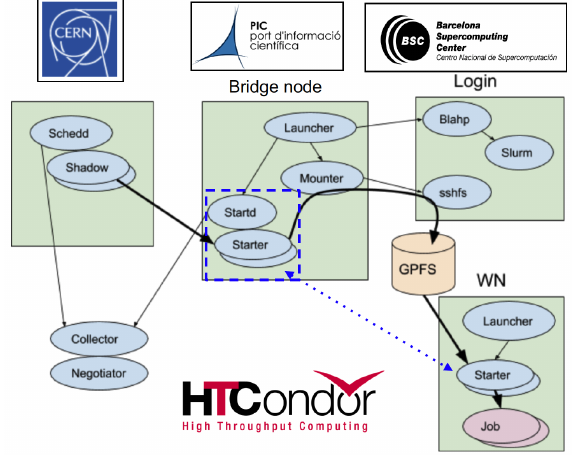
Figure 4. HPC resources at BSC integration model into CMS computing using communication via FS to replace WAN. A brid g e node installed at PIC submits Slurm jobs to BSC queues, that, upon execution, instantiate HTCondor starters on the BSC WN. These starter processes update their status to the mirror starter processes running at PIC, at the other side of the network barrier. In order to enable this mirroring, job input sandboxes and status signals are regularly synchronized between the bridge to the WN at BSC, passing .tar files via gpfs. The startd process at PIC opens to matchmaking by CMS job schedds at CERN, passing payload jobs to the starter, and via FS synchronization, to the BSC WN. From a functional perspective, in this model, the node at BSC has joined the HTCondor pool at PIC, federated to CMS Global